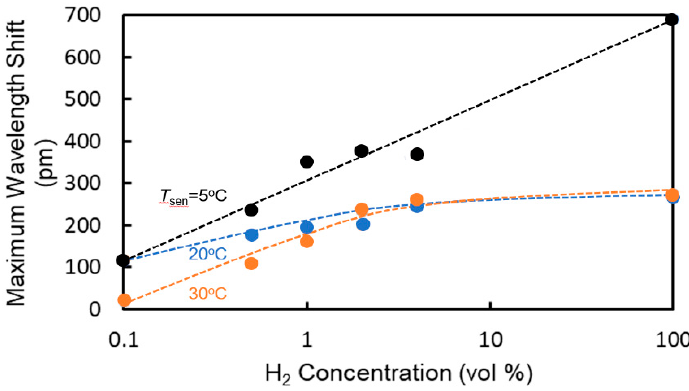
Figure 11. Dependence of wavelength shift at an elapsed time of 10 s on hydrogen concentration.